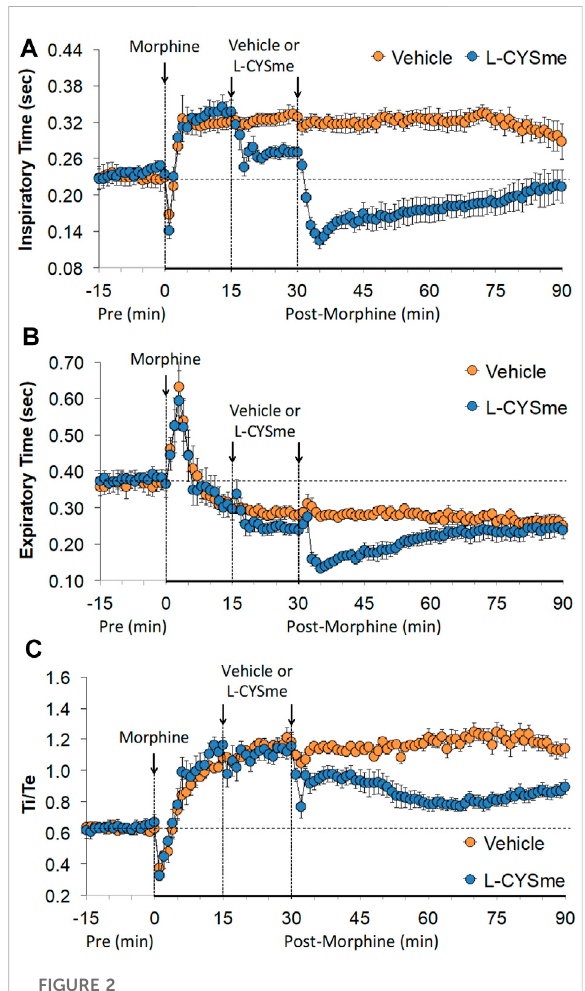
FIGURE 2 Inspiratory time Panel (A) , expiratory time Panel (B ) and inspiratory time/expiratory time (Ti/Te) Panel (C) prior to (Pre), following the injection of morphine (10 mg/kg, IV), and then two injections of vehicle or L-cysteine methyl ester (L-CYSme, 500 μ mol/kg, IV) given 15 min apart, in freely-moving rats. The data are shown as mean ± SEM. There were 6 rats in each